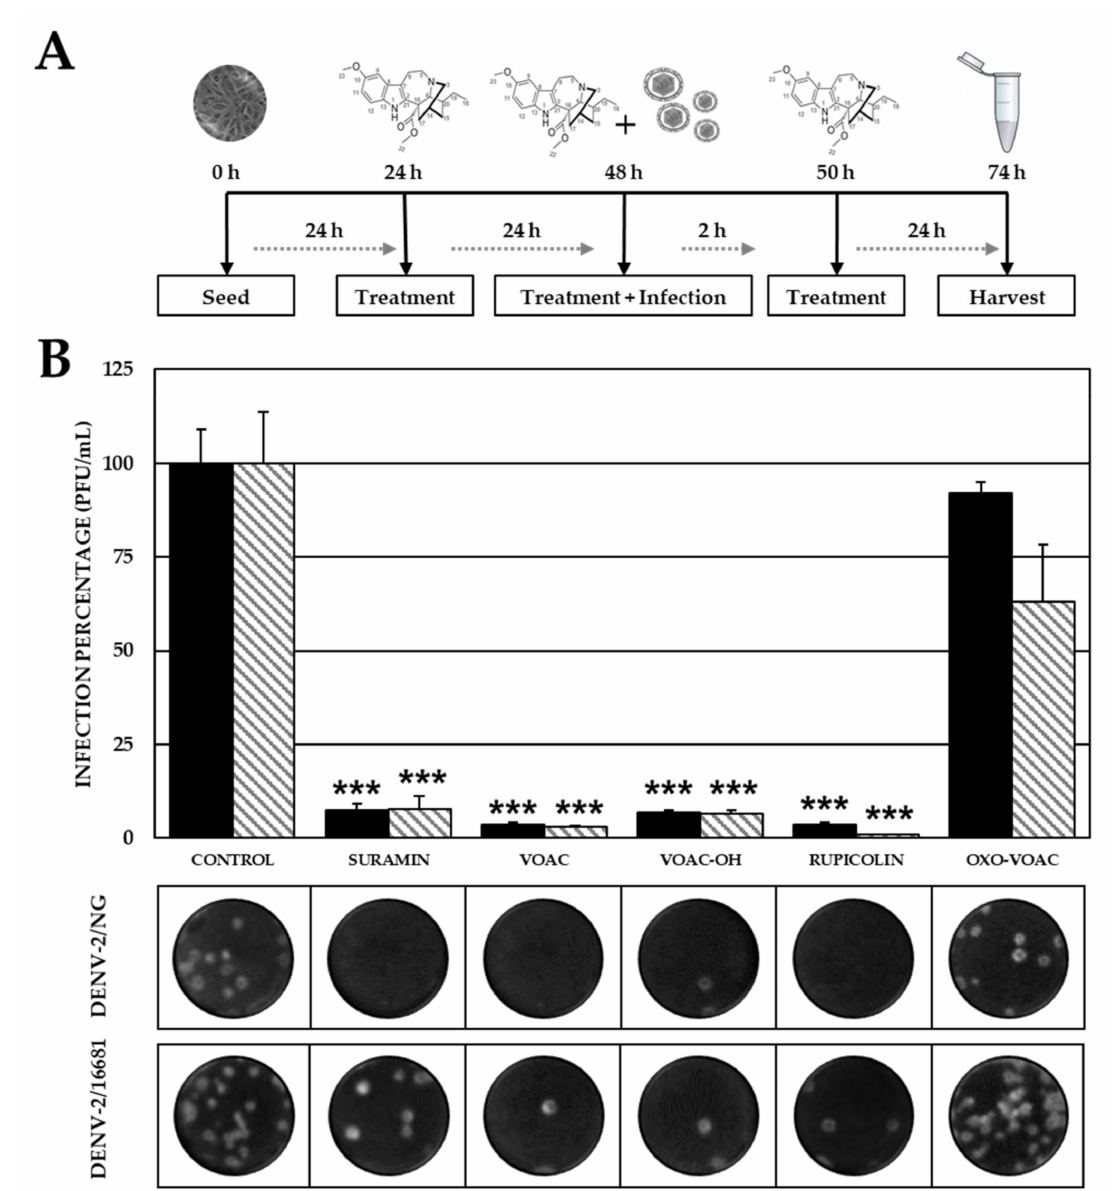
Figure 6. Anti-DENV-2 activity with the Combined treatment strategy. ( A ) Schematic representation of the combinate treatment strategy explained in the Materials and Methods section. ( B ) Infection percentage in each experimental condition. Vero cells were treated with each one of the compounds previous, during and after the infection with DENV-2/NG (Dark bars) or DENV-2/16681 (Clear bars). The asterisks indicate statistically significant differences with respect to the control without compound (*** p < 0.001; t -Student) and error bars indicate standard error of the mean; n : 4. Moreover, it shows representative images of plaque formed in each experimental